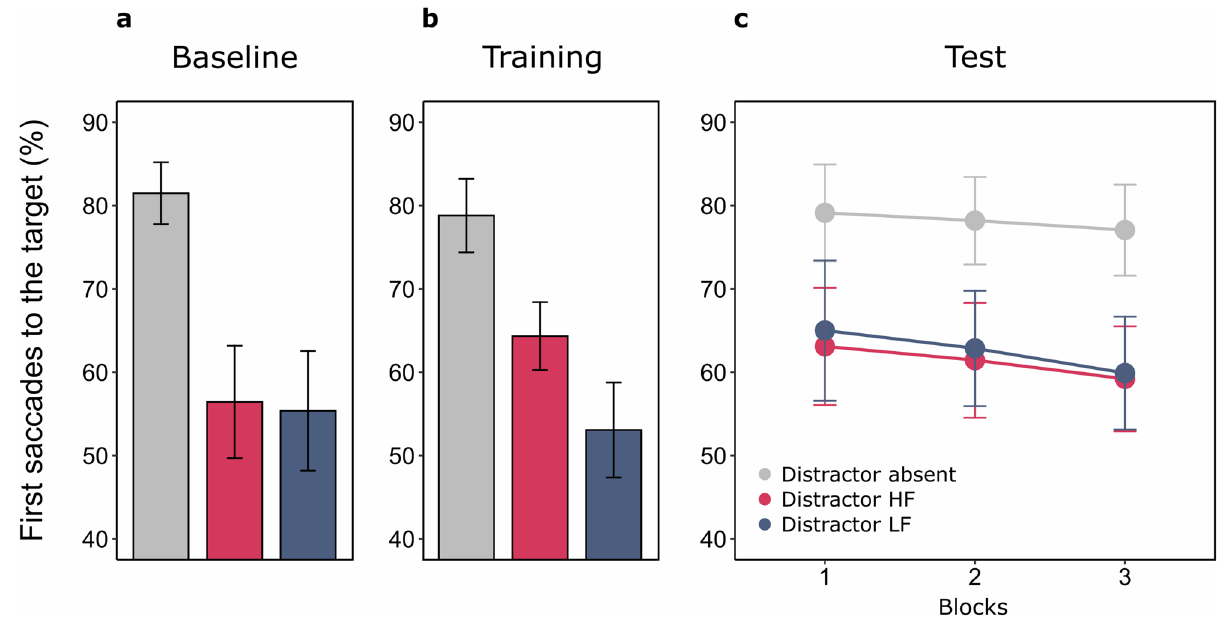
Figure 3. Mean percentages of target-directed saccades as a function of Distractor condition in Experiment 1. ( a ) Performance at baseline. ( b ) Performance at training. ( c ) Performance at test. Here and in all the other Figures, error bars depict the 95% within-subject confidence intervals 47,48